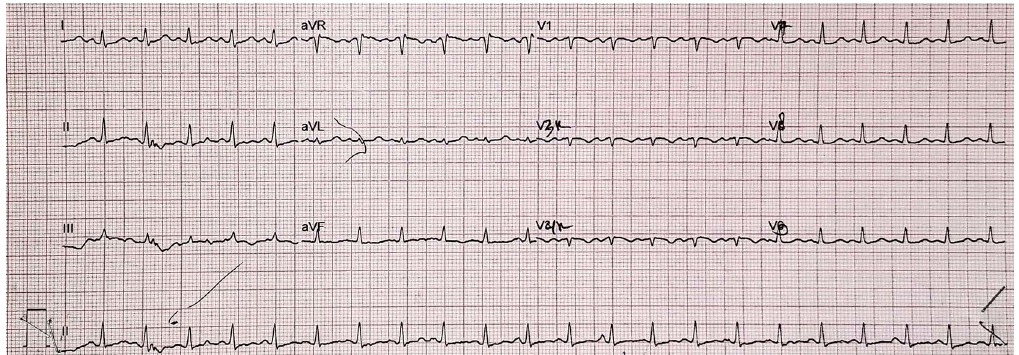
Figure 2. The patient's initial electrocardiogram in the